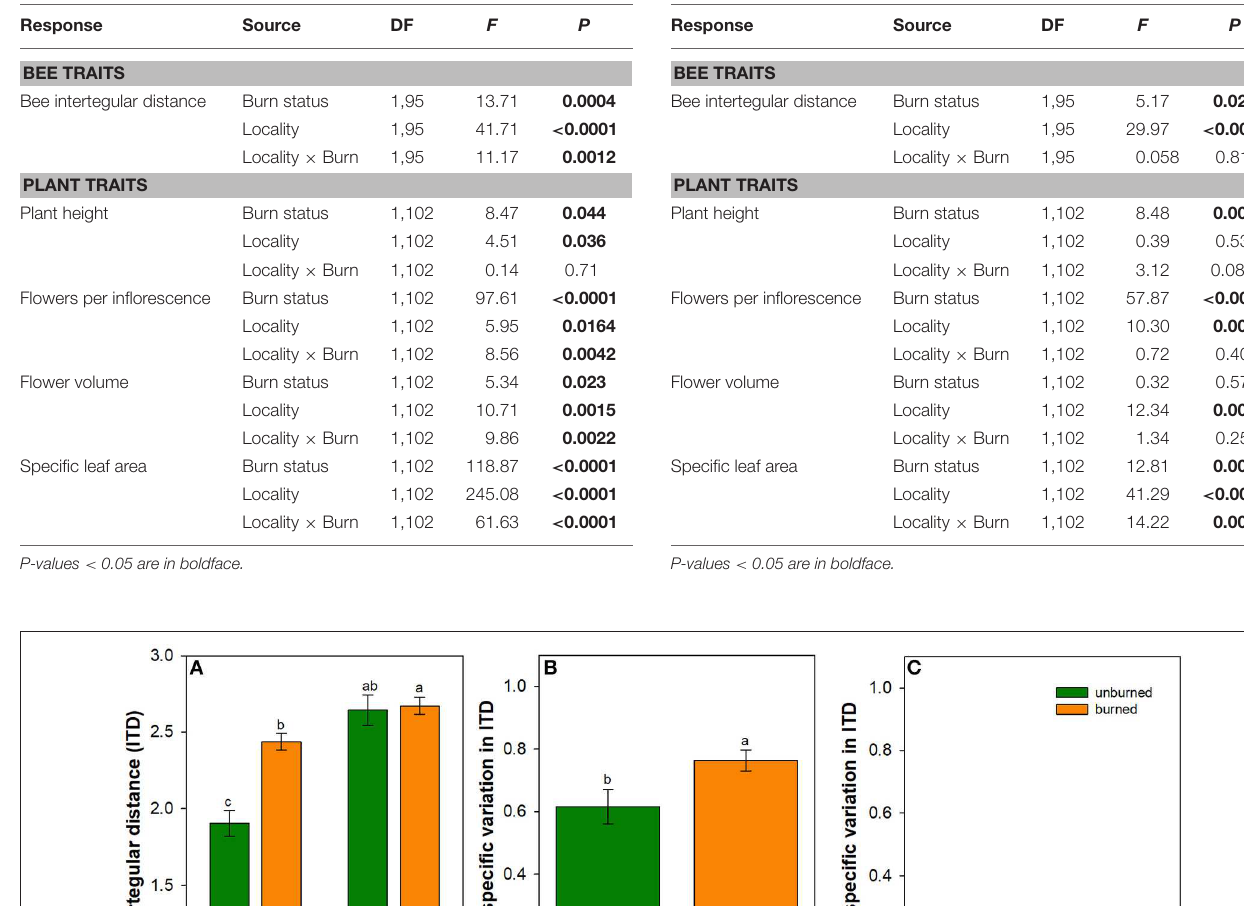
TABLE 2 | Results of two-way ANOVAs testing the effects of wildfire (i.e., burn status as burned or unburned), locality (i.e., Helena or Paradise) and their interaction on the mean values of bee and plant traits of all individuals and species measured across plots.